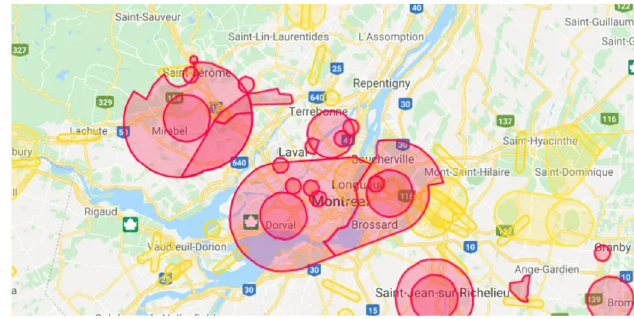
Figure 1. No ‐ Fly Zone in Montreal from DJI. Figure 1. No-Fly Zone in Montreal from